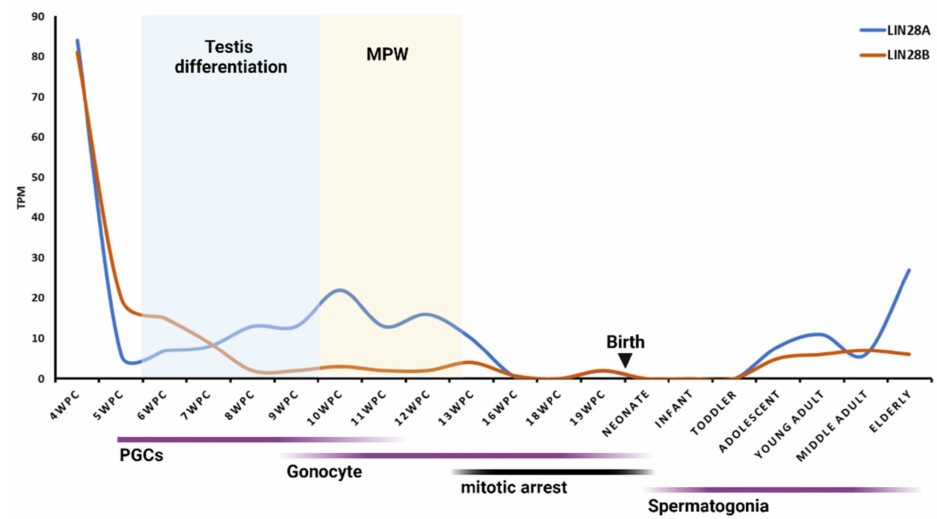
Figure 2. mRNA expression of LIN28AB across human testis development. Expression levels of LIN28AB mRNAs are shown in transcripts per million (TPM). MPW—masculinization programing window. Data available free online [58,59]. Graph created with BioRender.com (accessed on 4 May